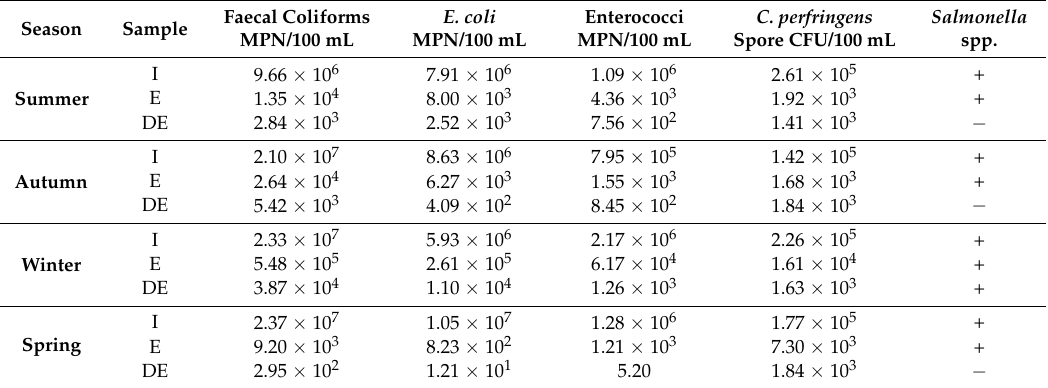
Table 4. Concentrations of microbial indicators in the three sampling points.